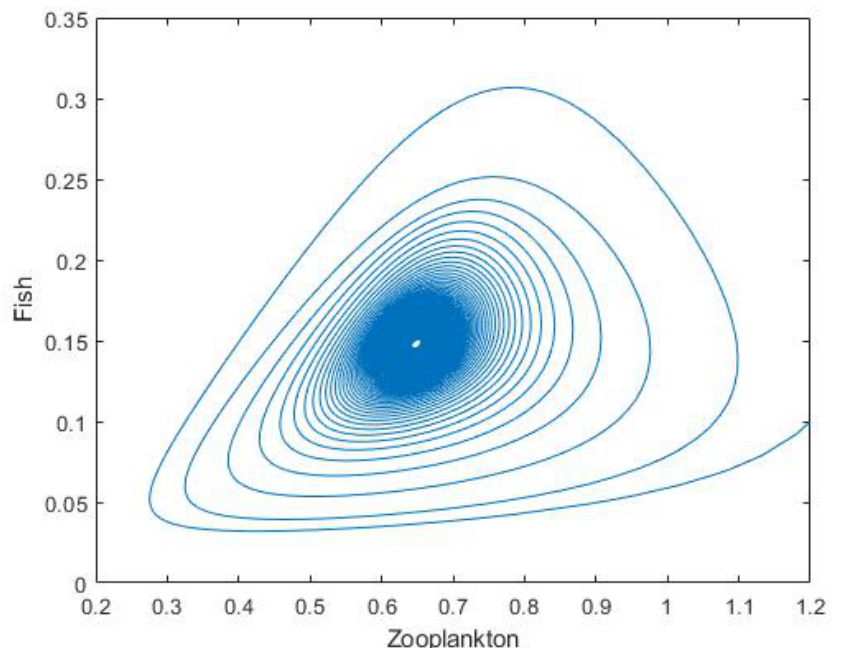
Figure 31. Equilibrium between the zooplankton and fish populations loses its stability for τ = τ −